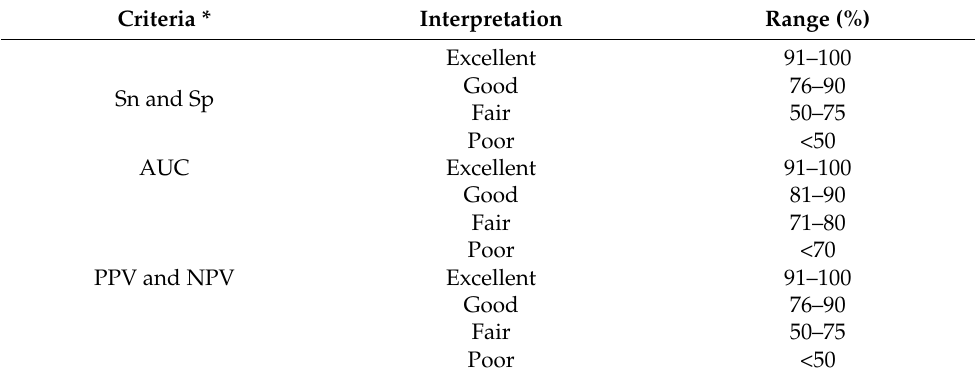
Table 1. Validity criteria for cognitive tools. Criteria